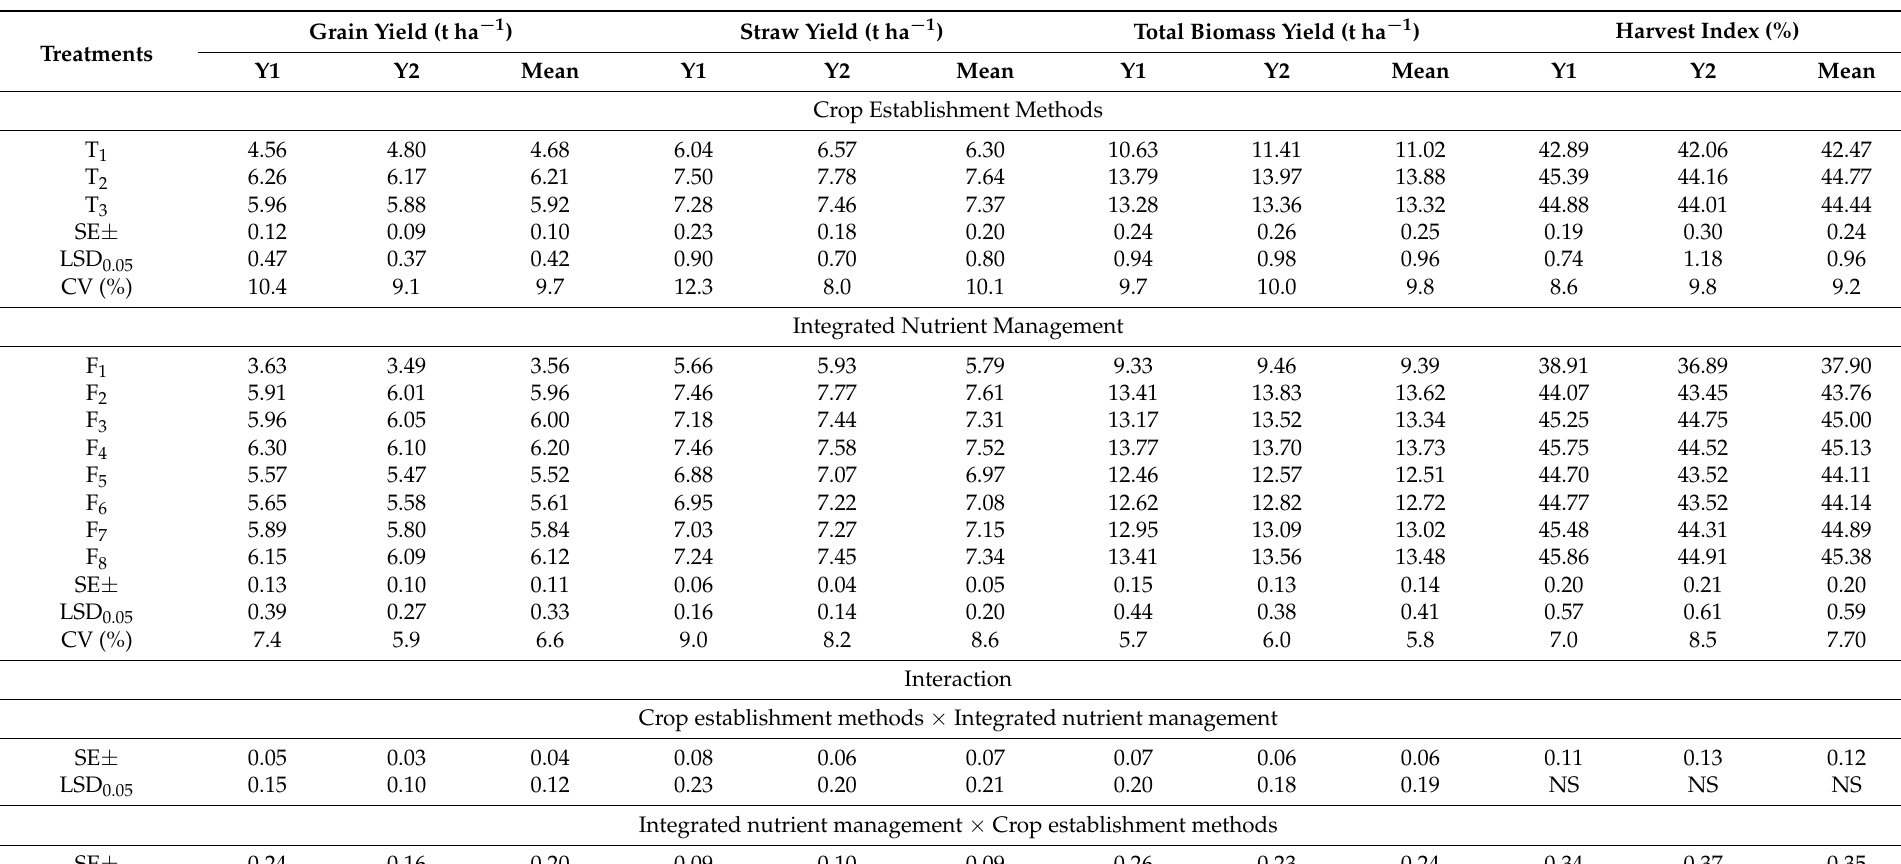
Table 4. Crop establishment methods and integrated nutrient management influenced the productivity of rice.